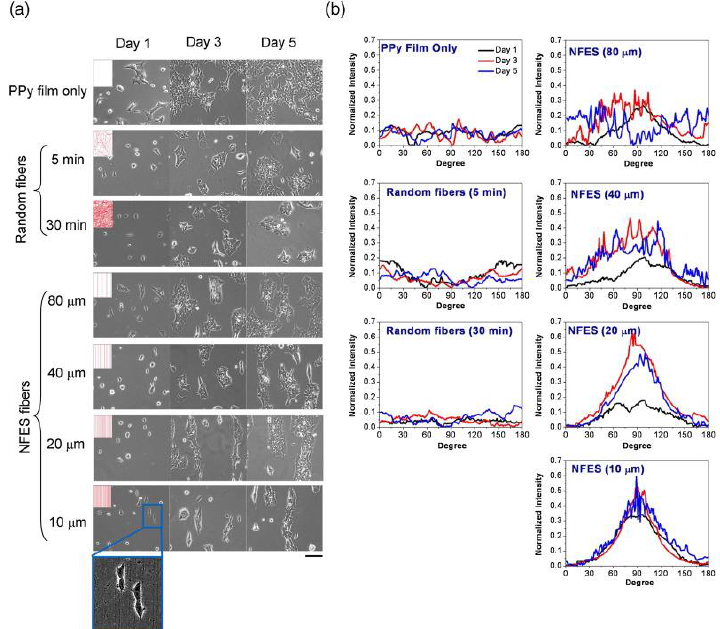
Figure 1. Cell alignment on near-field electrospinning (NFES) fibers. ( a ) HEK 293T cells were seeded to PPy films, randomly deposited alginate fibers, or NFES alginate fibers deposited surfaces. The distribution and morphology of surface cells were observed by a phase contrast microscope (scale bar = 100 μm). ( b ) Cell images were analyzed by fast Fourier transform (FFT) to determine the levels of cell alignment. Reproduced with permission from Fuh et al., Materials Science and Engineering: C; published by Elsevier, 2016.